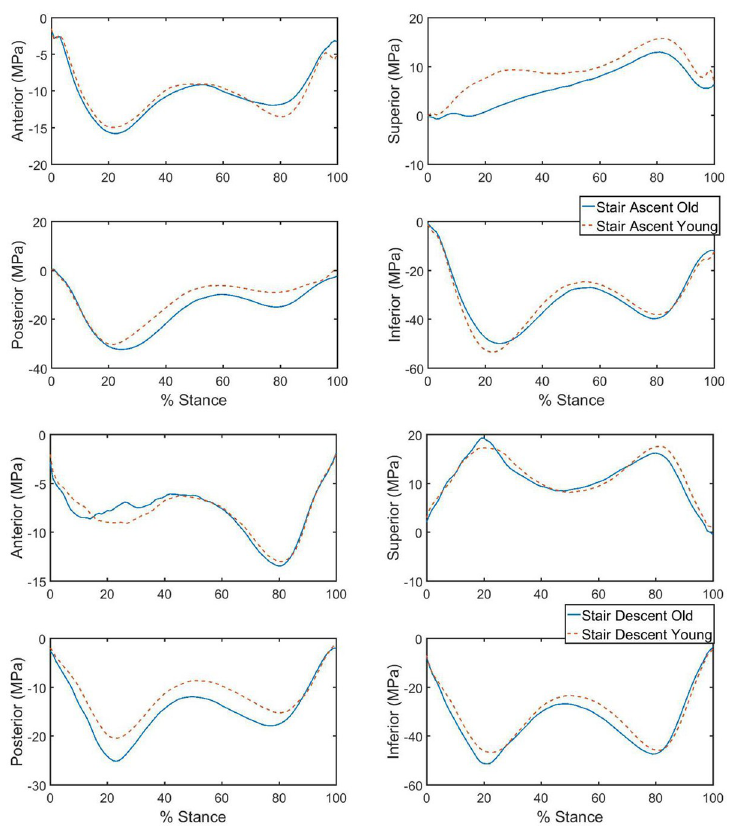
Fig 4. Ensemble average of stresses at 4 sites of femoral neck during stair ascent (top) and descent (bottom). Positive values indicate tension, negative values indicate compression.